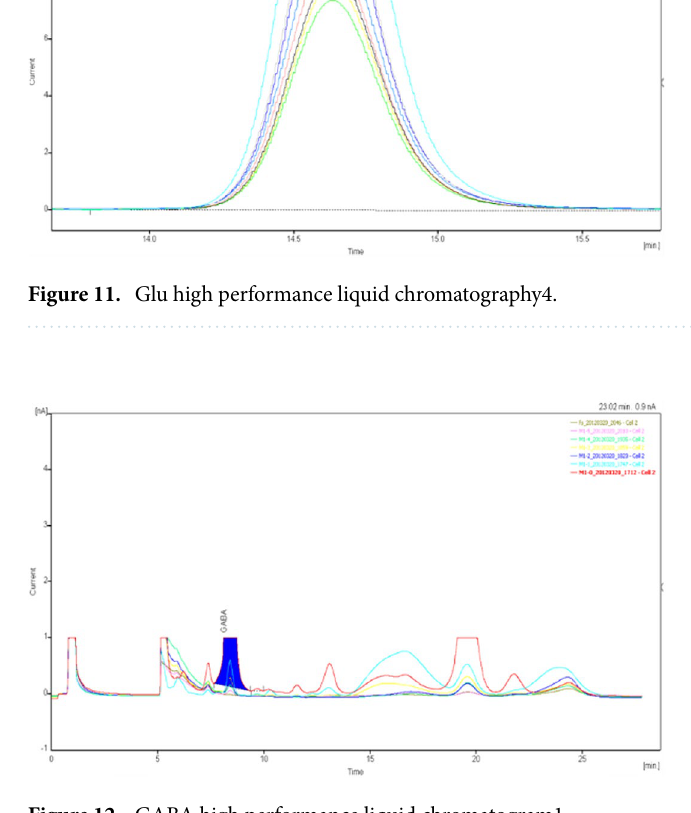
Figure 12. GABA high performance liquid chromatogram1.